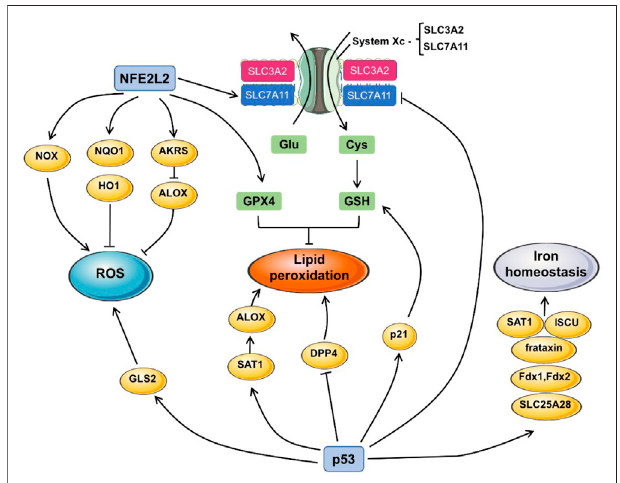
FIGURE 3 | The pathway of p53 and Nrf2 in ferroptosis. The generation of ROS, lipid peroxidation and iron homeostasis are the indispensable course in triggering ferroptosis. Nrf2 and p53 participate in ferroptosis by in fl uencing the expression of a series of downstream proteins. For example, Nrf2 promotes the expression of GPX4 and upregulates the expression or the functionofsolutecarrierfamilysevenmember11(SLC7A11)toexertin fl uence on lipid peroxidation. Nrf2 also activates NADPH oxidases (NOX), NAD(P)H quinone dehydrogenase 1 (NQO1), heme oxygenase 1 (HO1), aldosterone reductases (AKRS), which all contribute to the production of ROS, resulting in ferroptosis. GLS2 induced by p53 inhibit the depletion of ROS. P53 also promotethesynthesisofSpermidine/spermineN1-acetyltransferase1(SAT1) and dipeptidyl peptidase 4 (DPP4), which enhance the lipid peroxidation. P53 also regulates frataxin, ferredoxin one and 2 (Fdx1/Fdx2), iron-sulfur cluster assembly enzyme(ISCU), SAT1,theactivationofthosemolecules contributes to iron